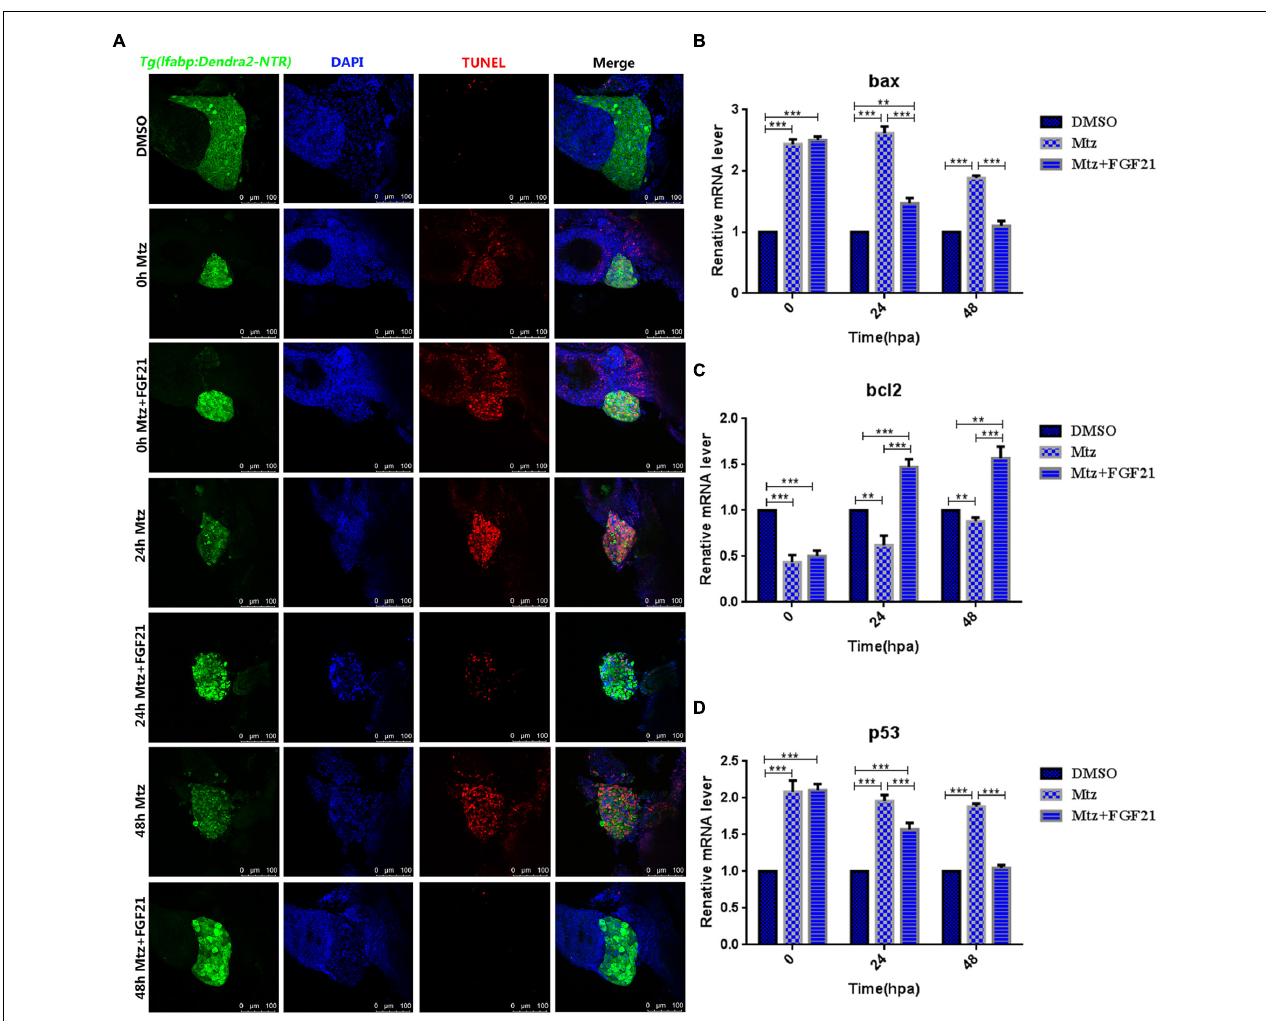
FIGURE 2 | Fibroblast growth factor 21 inhibits liver cell apoptosis after injury. (A) TUNEL assay performed to assess the level of DNA damage in the damaged liver (nuclei, blue; damaged DNA, red; and liver cells, green). (B) RT-qPCR detection of bax mRNA of three groups at 0, 24, and 48 hpa. (C) RT-qPCR detection of bcl2 mRNA of three groups at 0, 24, and 48 hpa. (D) RT-qPCR detection of p53 mRNA of three groups at 0, 24, and 48 hpa. DMSO group: without Mtz treatment, DMSO was applied. Mtz group: after Mtz treatment, grow naturally. Mtz+FGF21 group: after Mtz treatment, treated with FGF21 standard protein. Significance: ** p < 0.01, and *** p < 0.001 vs. DMSO group. Data are expressed as mean ± SEM ( n = 40 per group, repeat 3 times for each test). Scale bar = 100 µ